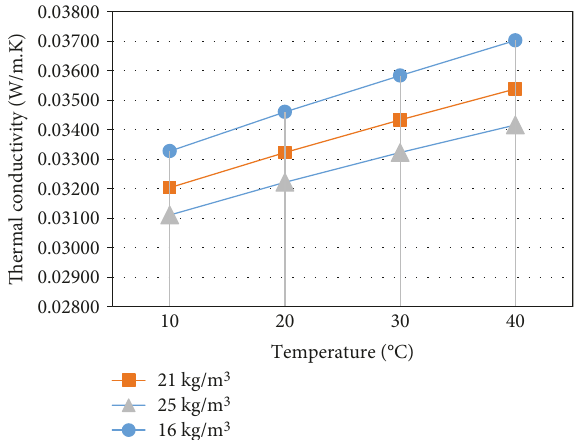
Figure 11: The change in the thermal conductivity with the temperature of the samples with di ff erent densities.